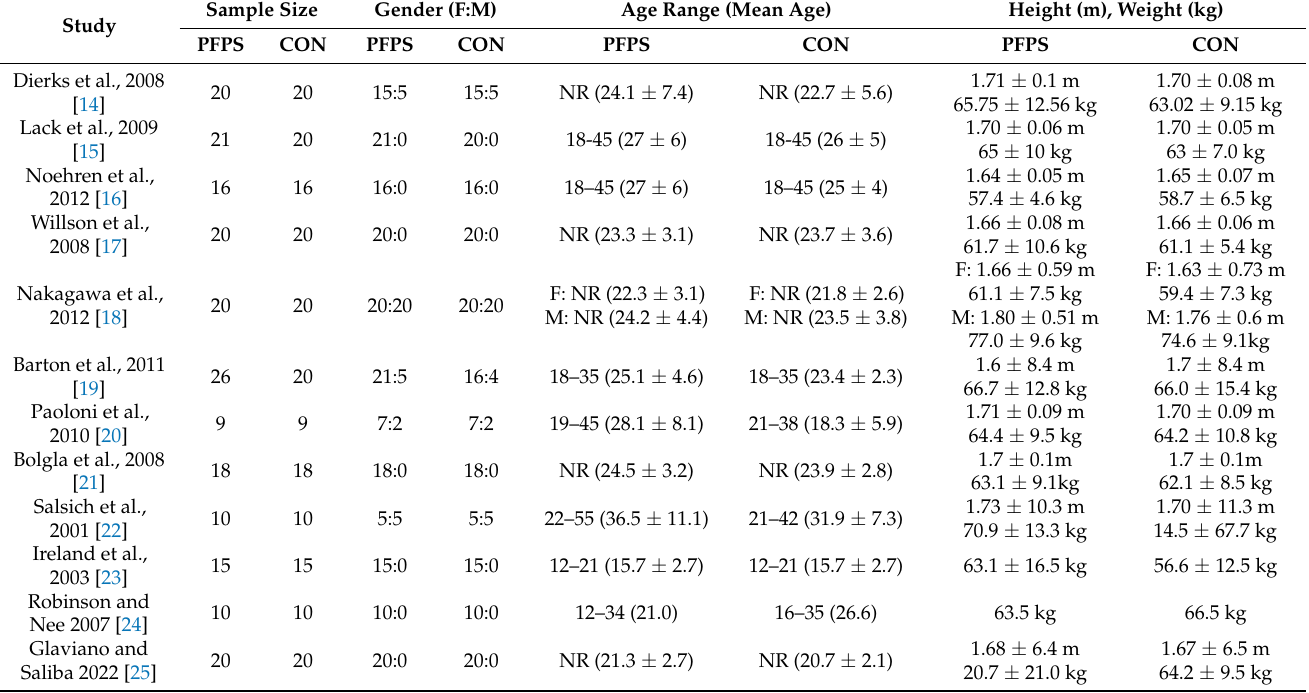
Table 2. Specific details about sample sizes, participant demographics, and population source of included